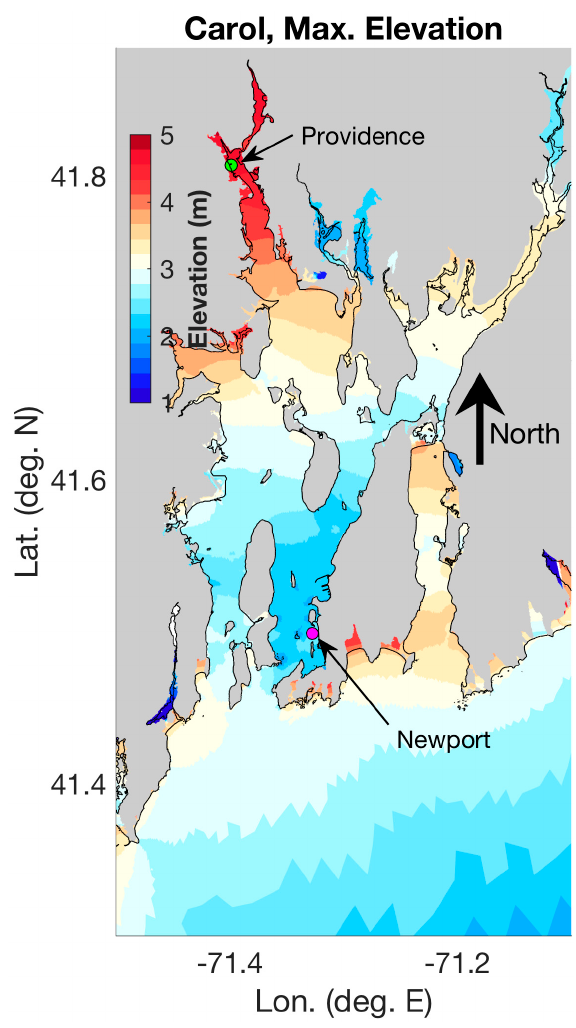
Figure 6. Simulated [ADCIRC / Simulating Waves Nearshore (SWAN)] maximum surface elevation for Hurricane Carol (1954) in the Narragansett Bay region with forcing from the hurricane boundary layer model. The mesh does not include the Fox Point Hurricane Barrier (FPHB), as this was not present at that time. The black line represents the coastline, and colored areas shoreward of the coastline represent areas experiencing overland flooding. The green and the magenta circles denote, respectively, the locations of the Providence and the Newport tide gauges.